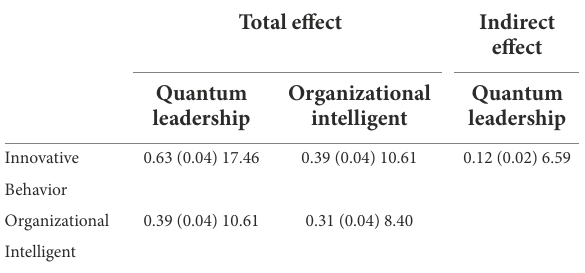
TABLE 5 Total and indirect